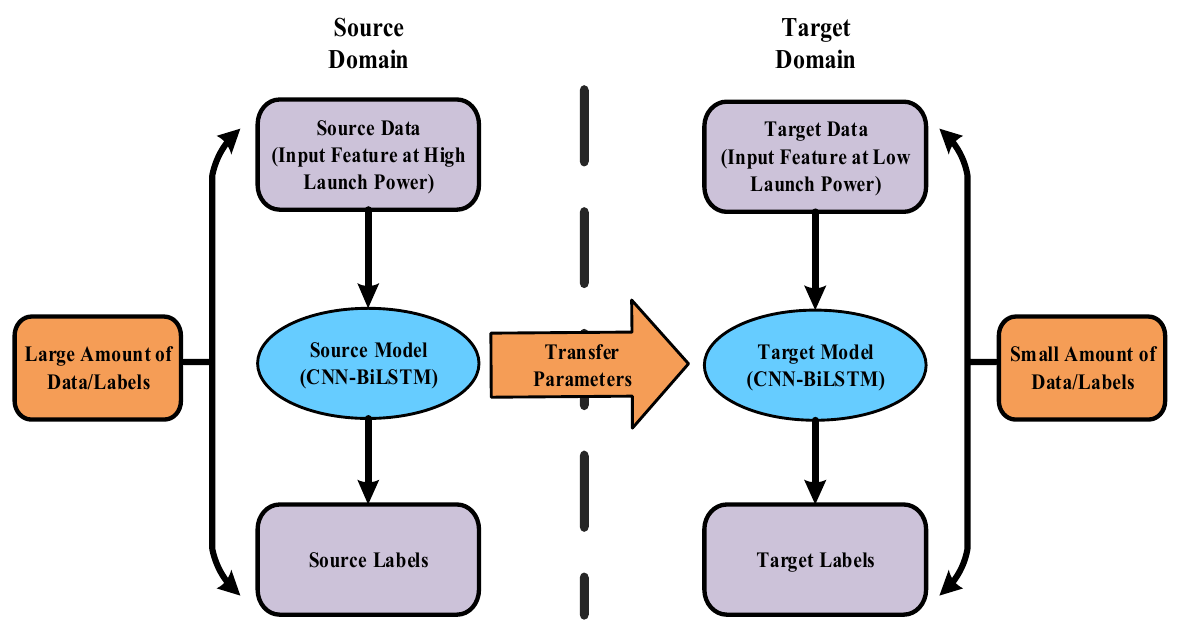
Figure 5. Schematic diagram of transfer learning simplified CNN-BiLSTM structure.